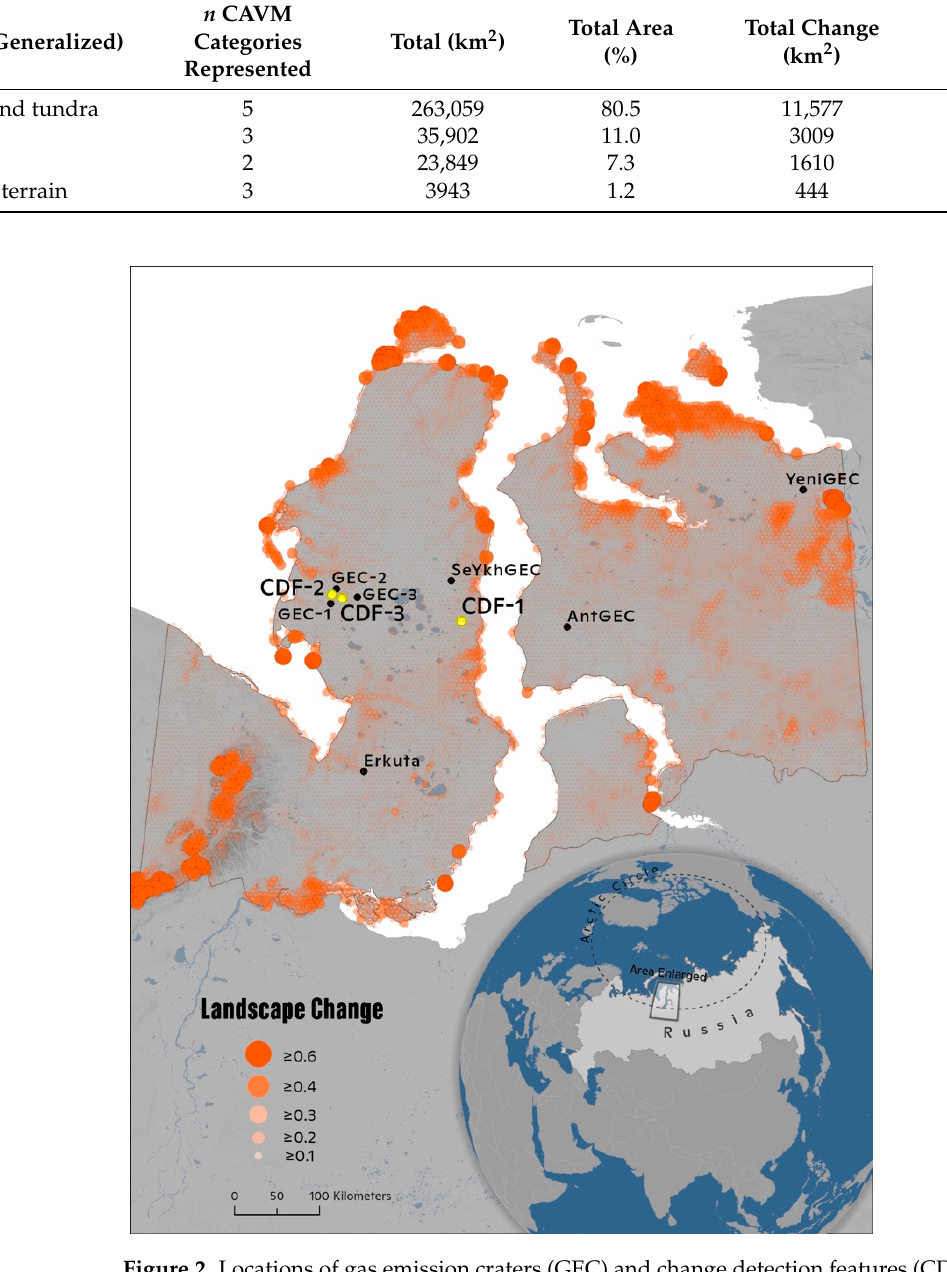
Figure 2. Locations of gas emission craters (GEC) and change detection features (CDF) identified by the change detection algorithm (CDA). Magnitude of landscape change was derived from the change pixels (see Section 2.2).